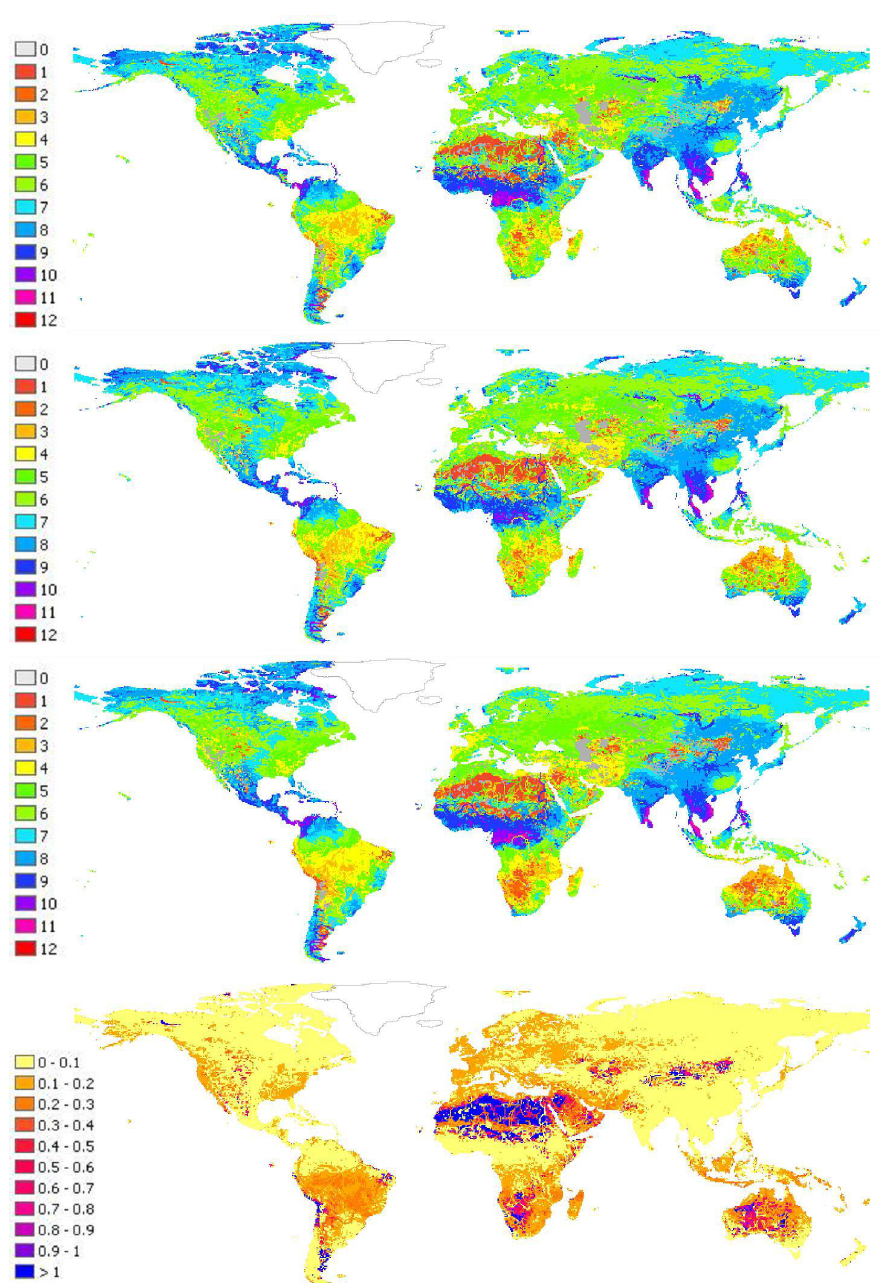
Figure 12: Thirty year average timing of peak discharge (month) calculated from a) the PCR-4 GLOBWB run forced with the ERA6190 dataset, b) the PCR-GLOBWB run forced with the5 ERACLM dataset, c) the ensemble mean discharge results of the 12 GCM based PCR-6 GLOBWB runs and d) the CV (-) of the thirty year average timing of peak discharge of the7 ensemble of